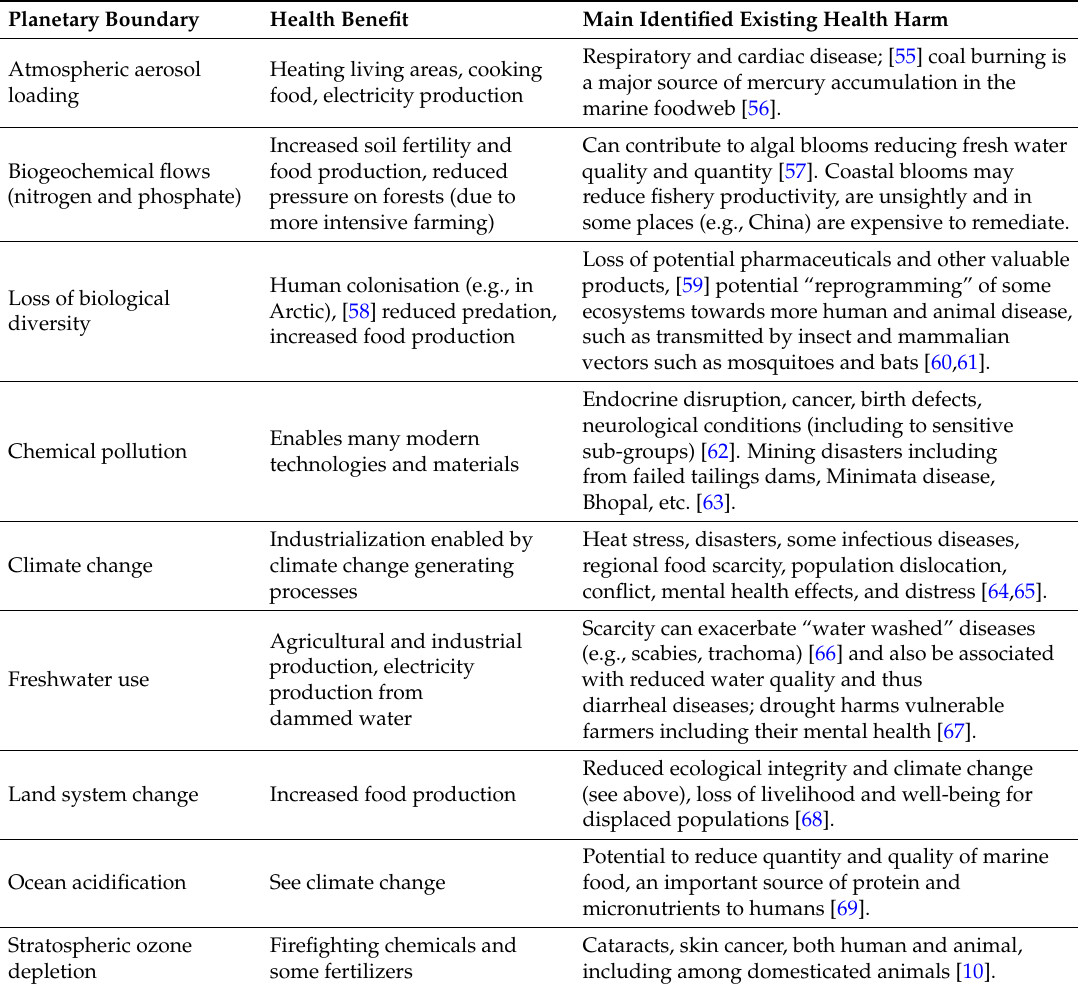
Table 1. The nine original planetary boundaries and some of their health